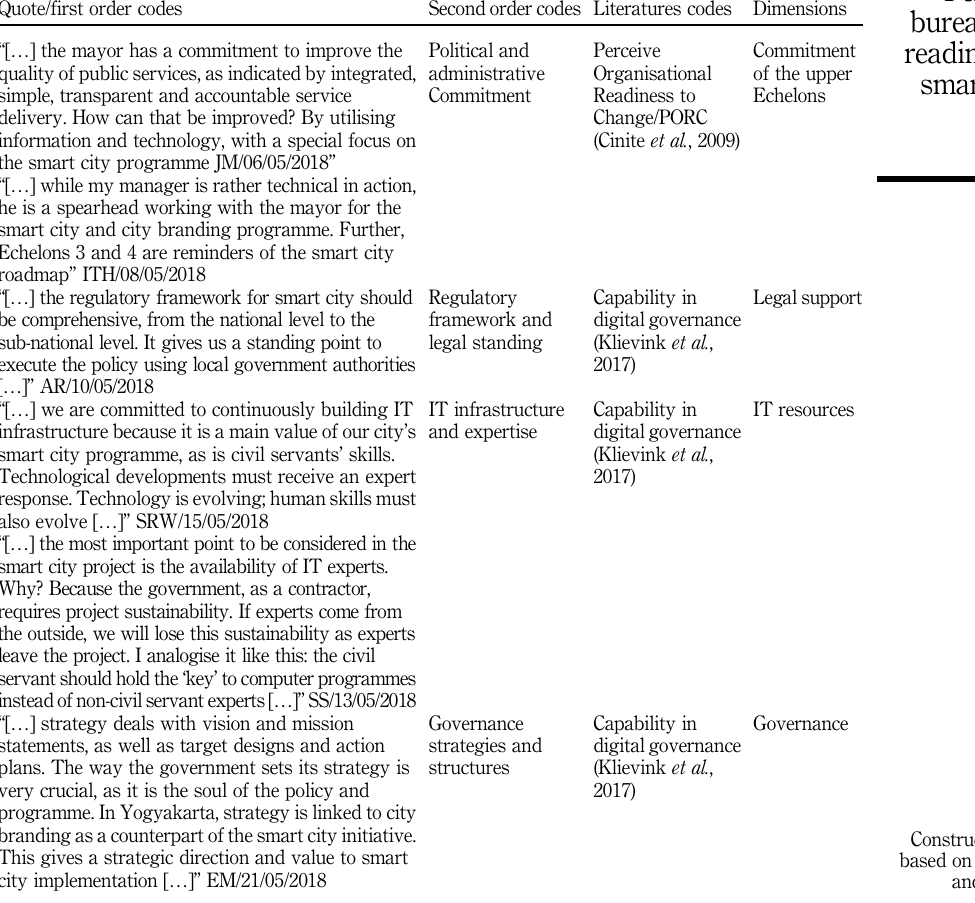
Table I. Construct